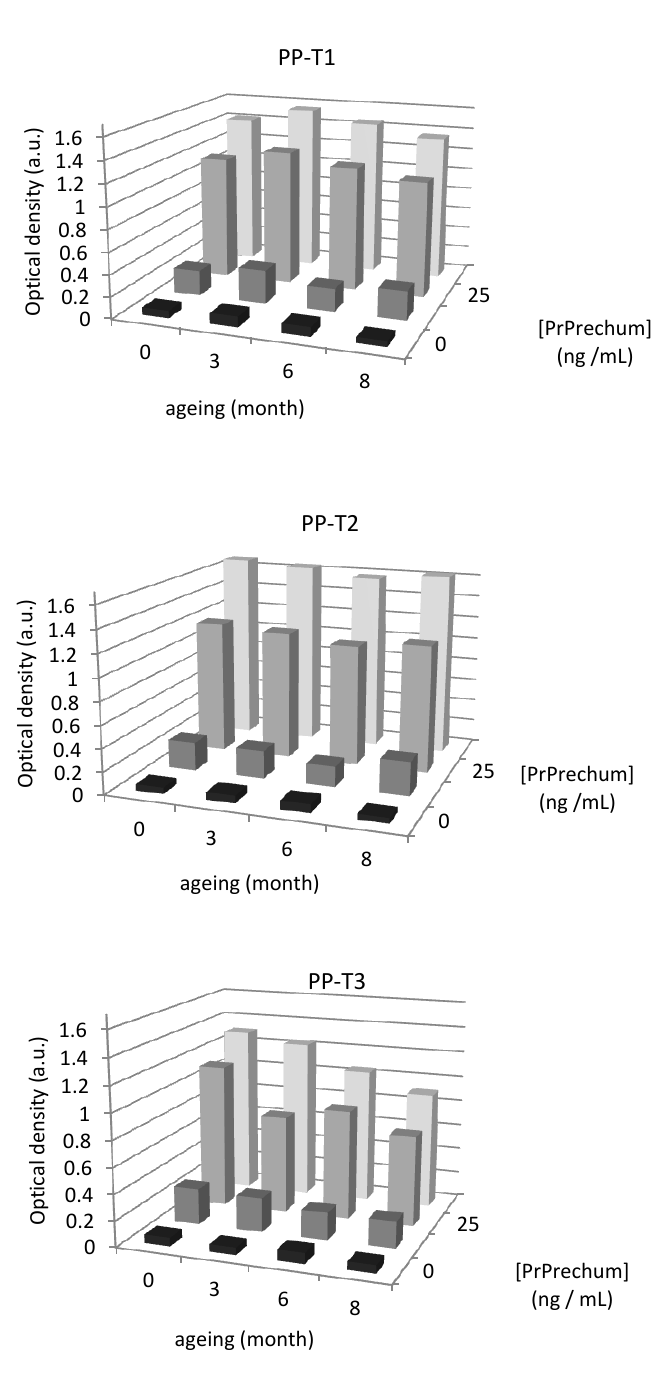
Figure 3. Evaluation of aging on the detection of PrPrechum protein with different surface chemistries of PP